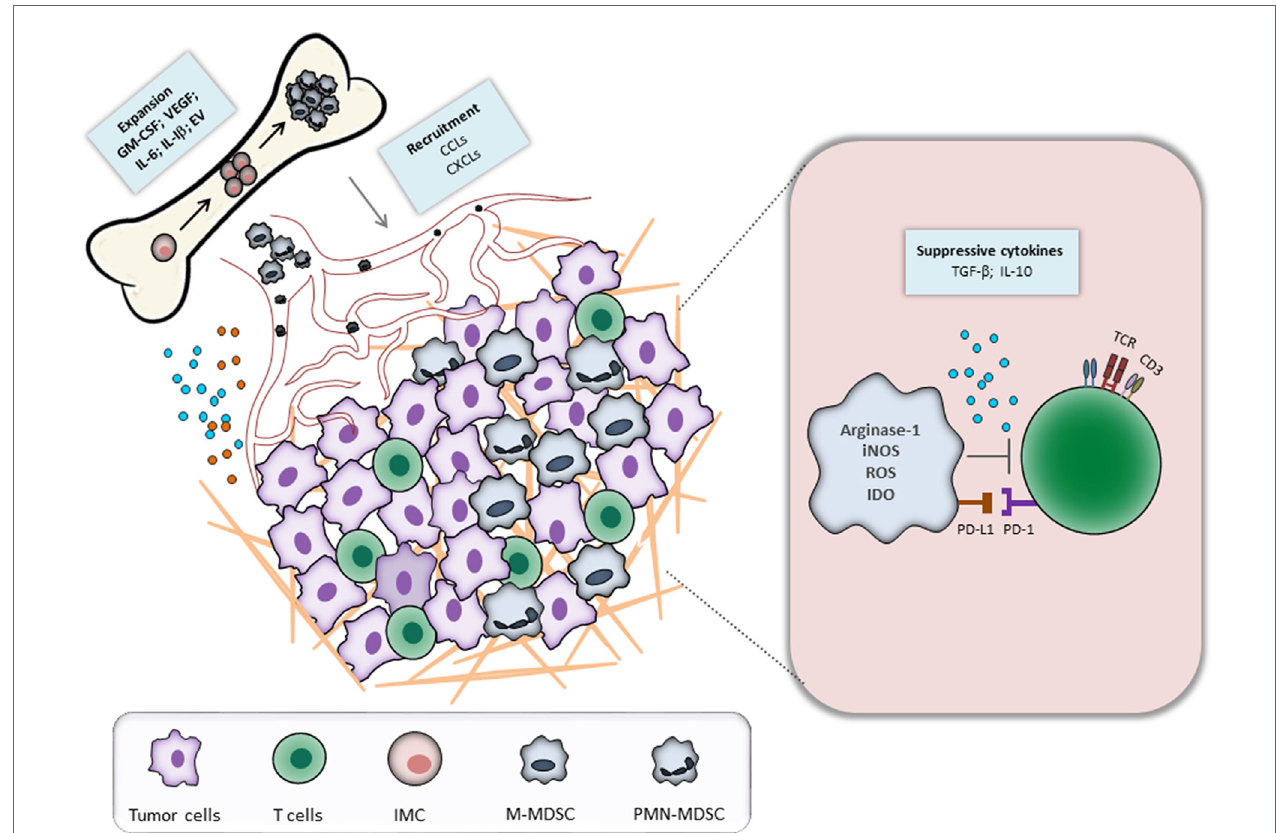
FiGURe 1 | Myeloid-derived suppressor cells (MDSC) recruitment and activation during tumor progression. Tumor and immune cells constantly release inflammatory mediators, leading to the dysregulation of normal myelopoiesis and to the conversion of immature myeloid cells (IMC) into MDSC in the bone marrow. The latter cells expand and migrate to the tumor site through the interaction between CCR and respective chemokines (CCL). In the tumor microenvironment, MDSC are activated and strongly inhibit an antitumor reactivity of T cells via various mechanisms.